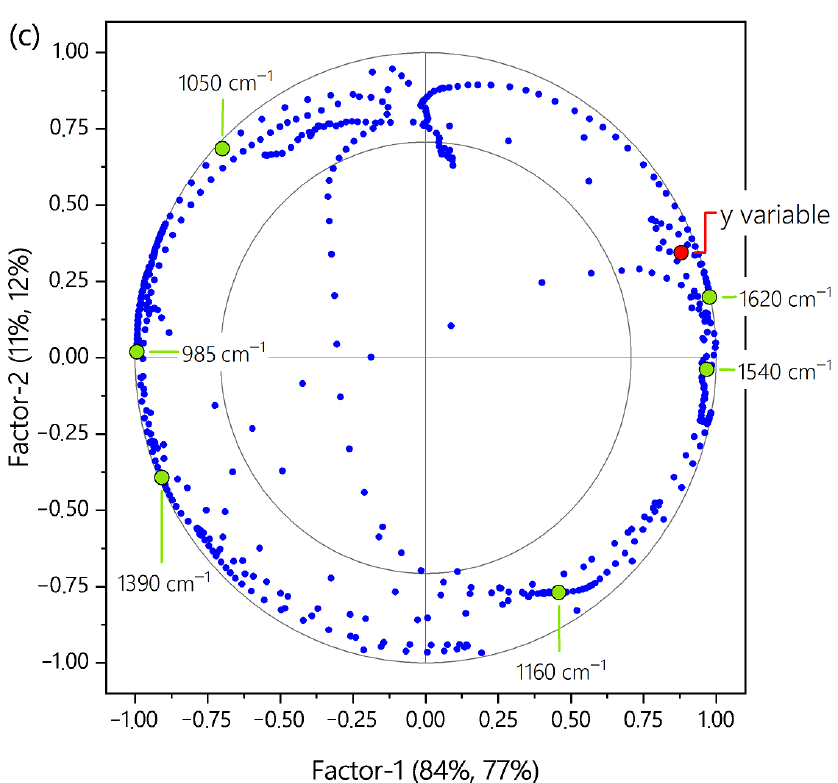
Figure 9. PLS model at TP for predicting residual curing capacity calculated with two factors. ( a ) Predicted vs. reference values for residual curing capacity. ( b ) Weighted regression coefficients for two factors vs. x-variables (fingerprint region 1750–750 cm −1 ). ( c ) Correlation loadings plot with outer-circle 100% explained variance, inner circle 50% explained variance, spectral input data (blue, green) and response residual curing capacity (red).